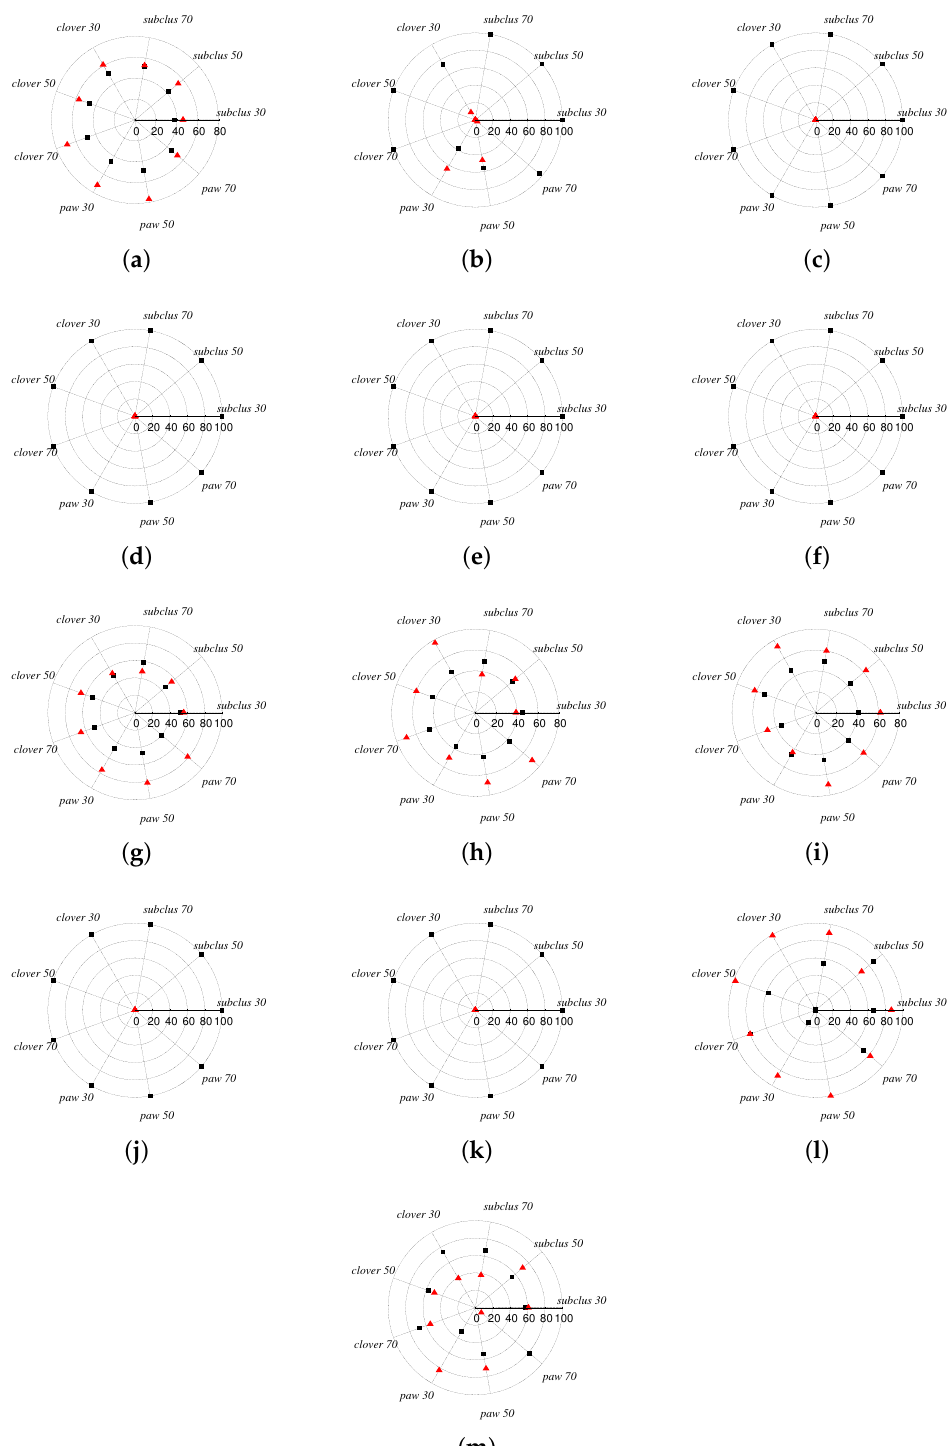
Figure 4. True-positive and true-negative rates using SVM on the synthetic data sets. ( a ) RUS; ( b ) CNN; ( c ) NCL; ( d ) TL; ( e ) ENN; ( f ) OSS; ( g ) EUS; ( h ) EE; ( i ) BC; ( j ) RUSBOOST; ( k ) SBC; ( l ) ClusterOSS; ( m )